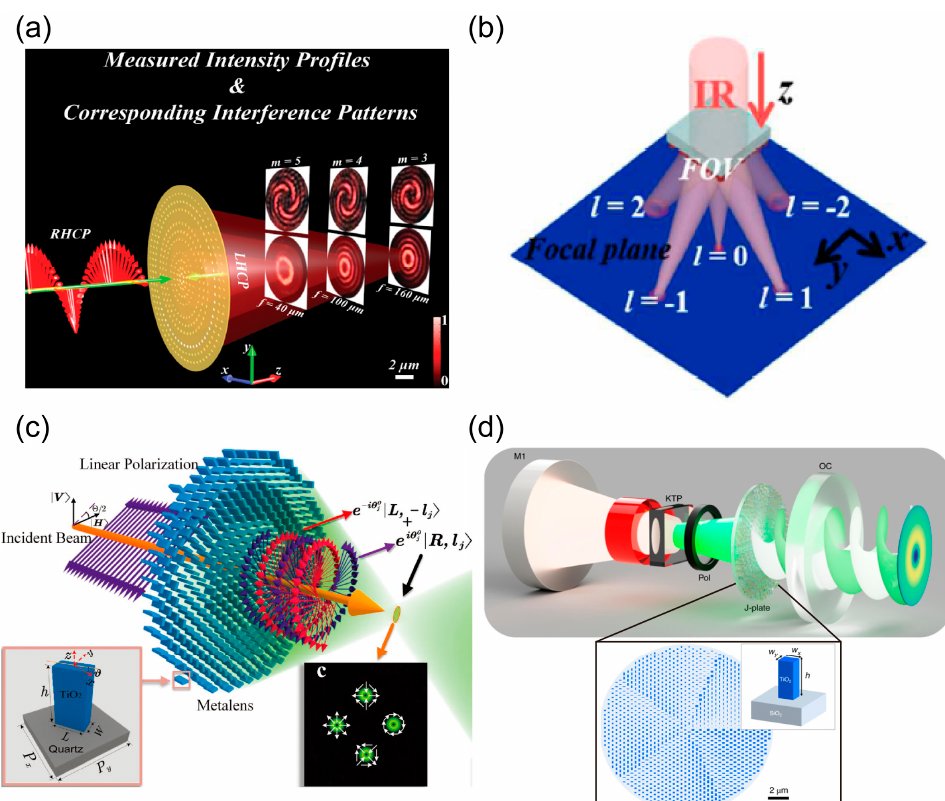
Figure 7. Generation and detection of optical vortices based on metasurfaces. ( a ) Generation of coaxial multi-channel optical vortices with metasurface [195]. ( b ) Schematic of the focusing optical vortex generator operating in transmission mode [196]. ( c ) Metasurface for generation of multi-channel vector optical vortices [197]. ( d ) Metasurface optical vortex laser [198].